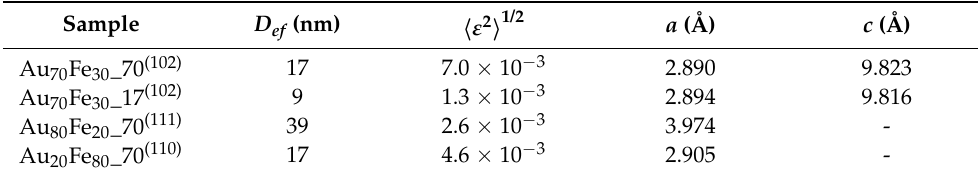
Figure 4. XRD data of 4H Au (102) diffraction peak in sample ( a ) Au 70 Fe 30 _70 and ( b ) Au 70 Fe 30 _17; fcc Au (111) for sample ( c ) Au 80 Fe 20 _70; and bcc Fe (110) in layer ( d ) Au 20 Fe 80 _70. The experimental data were fitted with Voigt profiles and the residual of the procedure is present at the bottom of each graph. Table 2. Structural parameters of Au x Fe 1-x thin films calculated from Voigt profile.